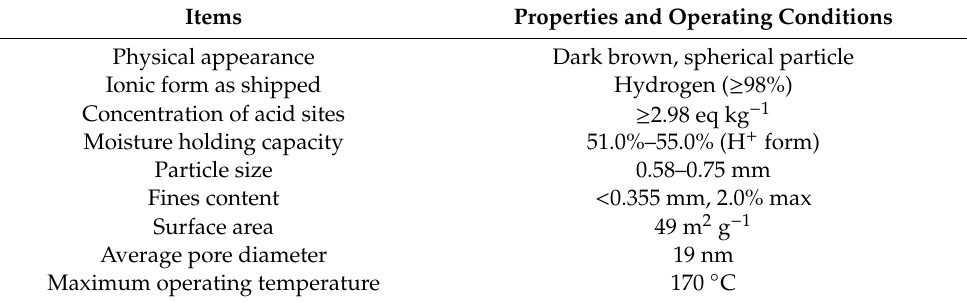
Table 1. Properties of cation exchange